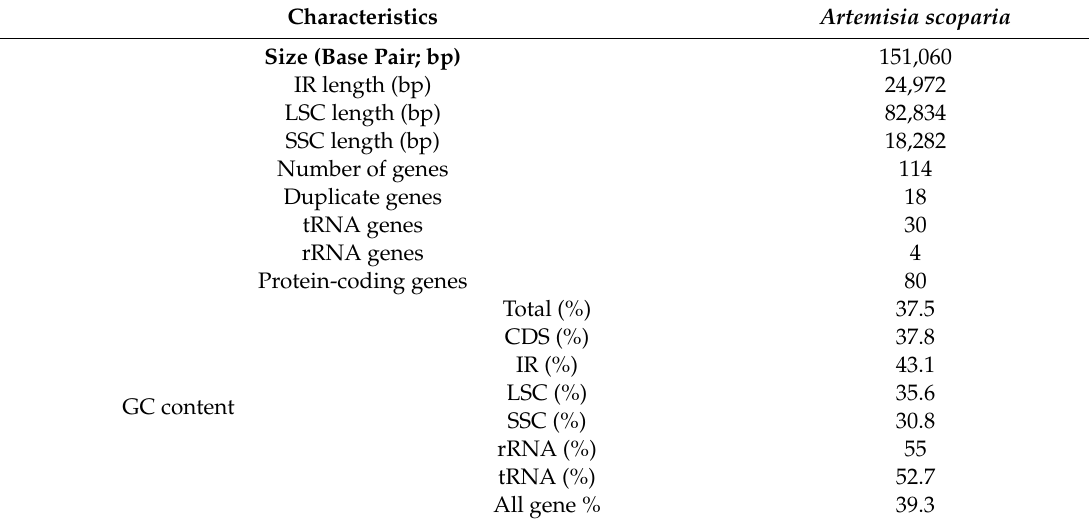
Table 1. Genomic features of Artemisia scoparia